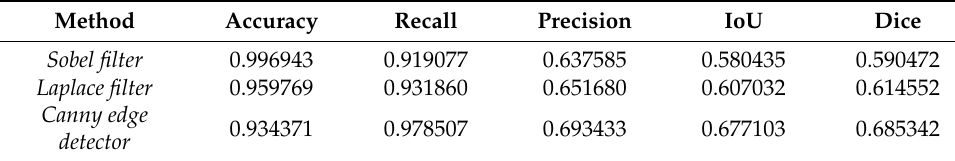
Table 3. Image processing methods performance